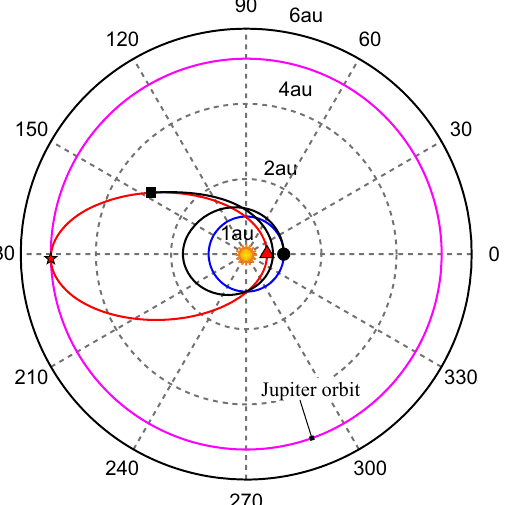
Figure 16. Optimal transfer trajectory in a Jupiter-based mission scenario with e f = 0.8077 and β = 0.1686.